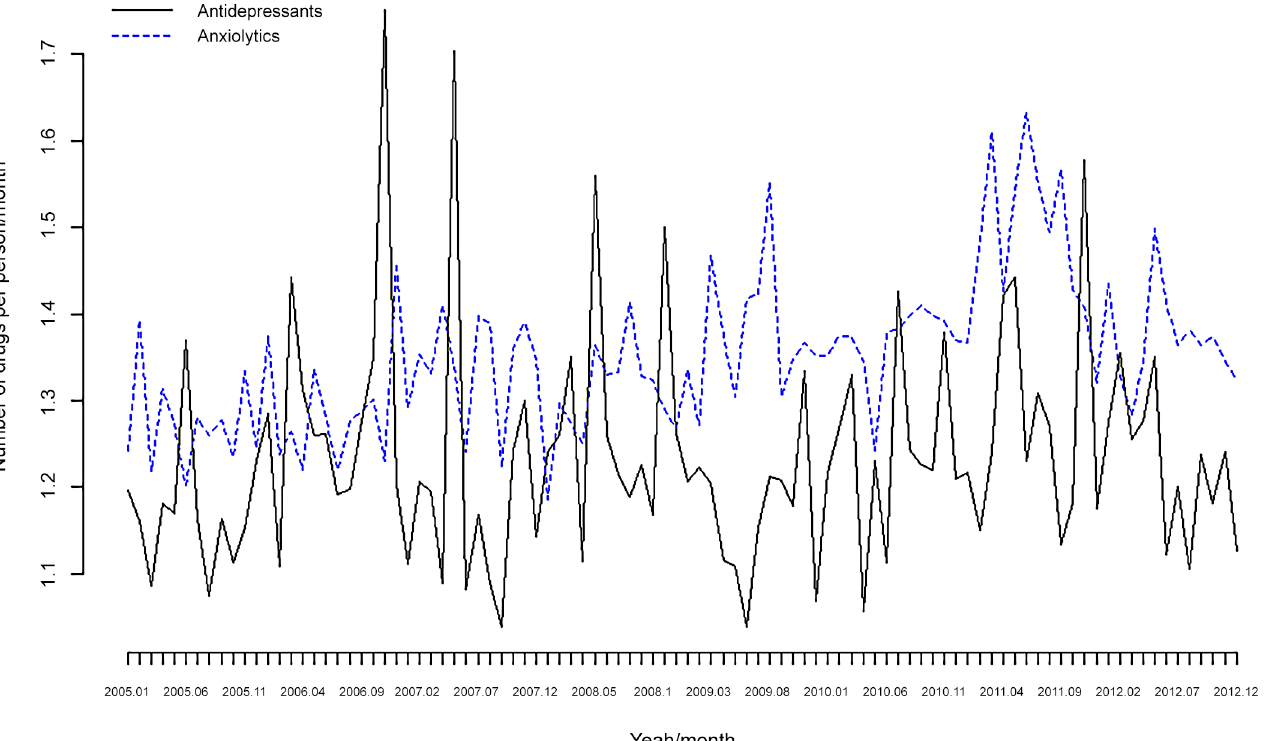
Fig 3. Consumption of psychotropic drugs. Antidepressants and anxiolytics. Number of drugs per person/month. Monthly data for the period 2005 –